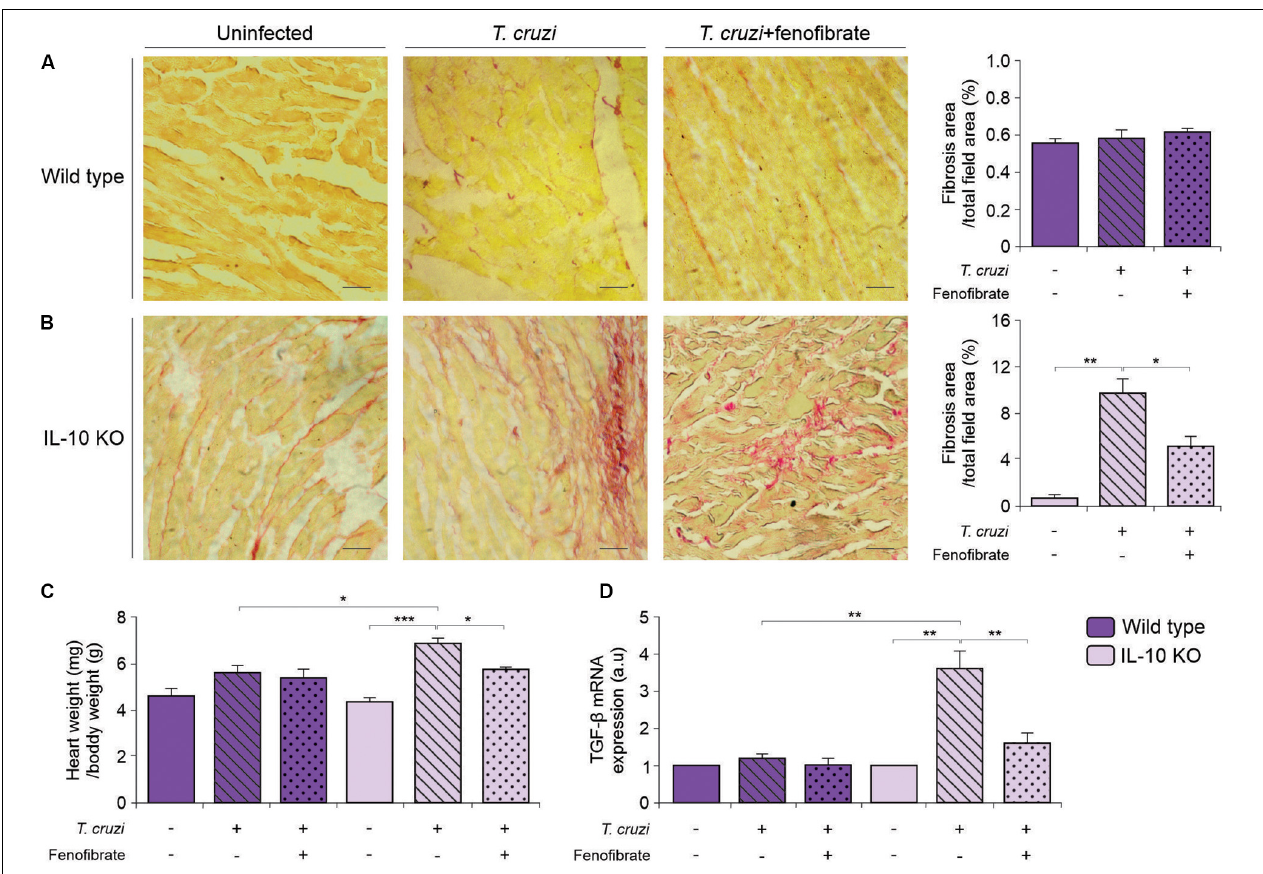
FIGURE 6 | Heart remodeling and fibrosis. Whole hearts where perfused, excised, and weighted. Fibrosis was evaluated in heart sections of uninfected (left panels), T. cruzi- infected (center panels), and T. cruzi- infected fenofibrate treated WT (A) and IL-10 KO (B) mice were stained with picrosirius red. Bar graphs to the right: quantitative analysis of fibrosis. (C) Heart/body weight ratio was evaluated in uninfected, T. cruzi- infected, and T. cruzi- infected fenofibrate-treated IL-10 KO and WT mice. (D) The expression of TGF- β was determined by qRT-PCR in heart homogenates of uninfected, T. cruzi- infected and T. cruzi- infected fenofibrate-treated IL-10 KO and WT mice. Differences between groups were analyzed by ANOVA (mean ± SEM) followed by Tukey post hoc test. Differences were considered significant when p < 0.05. 7 mice per group, 3 replicate experiments. * p < 0.05; ** p < 0.01; and *** p <